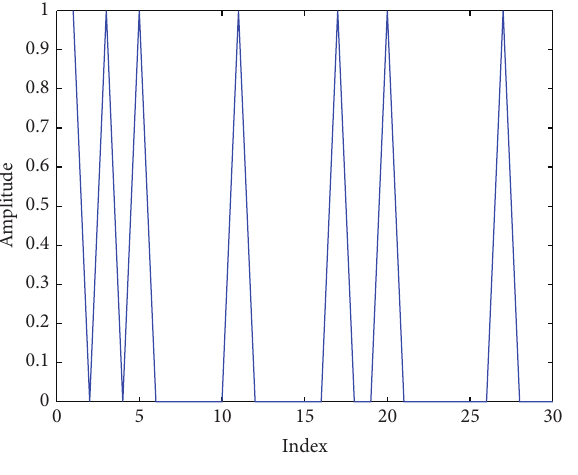
Figure 1: The original signal 𝑥 .